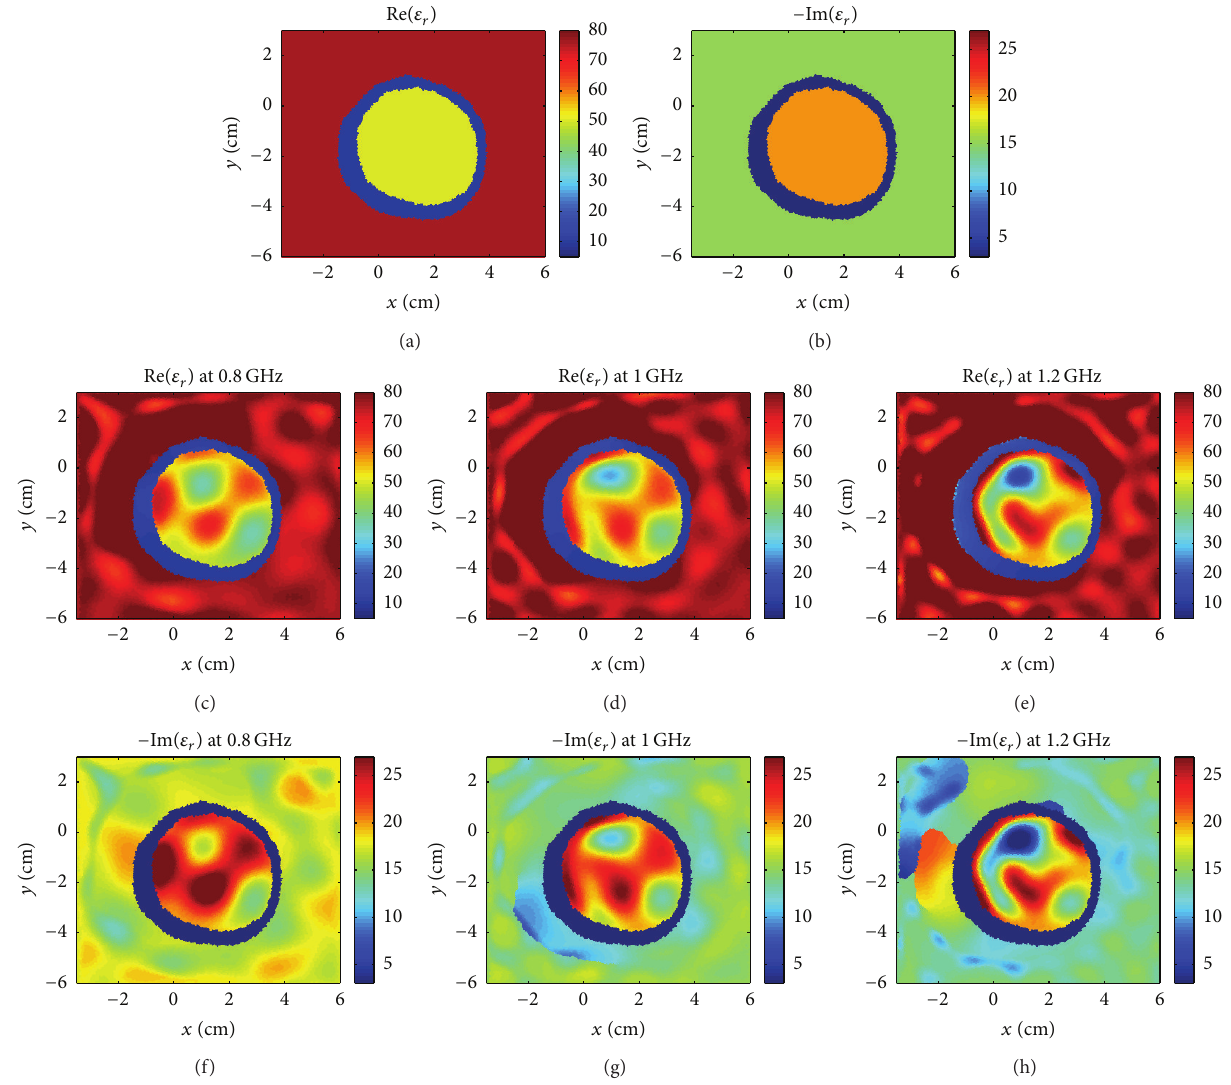
Figure 11: Volunteer 2: (a)-(b) prior information. The reconstruction when prior information is used as inhomogeneous background at (c), (f) 0.8 GHz, (d), (g) 1GHz, and (e), (h)